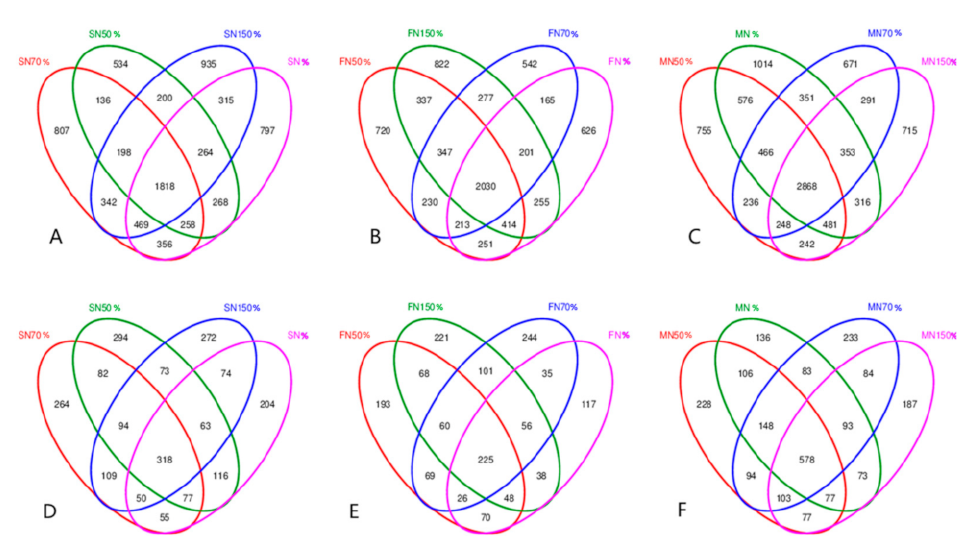
Figure 1. Venn diagram based on OTUs of bacteria and fungi in oilseed rape rhizosphere